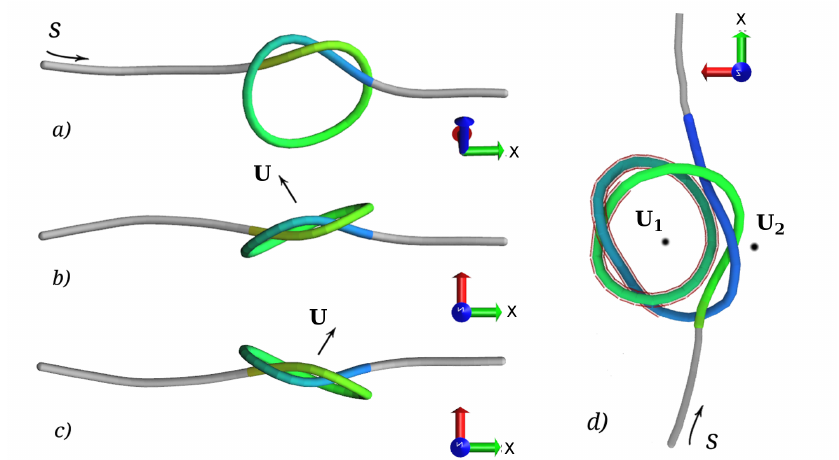
Figure 7. Left-handed 3 1 knot configuration obtained by minimizing the energy viewed from the side ( a ) and from the top ( b ); ( c ) Right-handed 3 1 knot viewed from above. X indicates the pulling direction. In ( a ), the direction of the arc length s is indicated by an arrow, and in all panels by the coloring of the knots, from green to blue for increasing s . In panels ( b , c ), we reported the direction of the vector U k defined in Equation (9). Note that U k · x changes sign with the handedness of the knot; ( d ) A ( + − ) intertwined composite knot, with the nested knot highlighted by a red shading. Note that when the loop of the nested knot lies inside the loop of the outer knot, both orientation directors point out of the page. On the other hand, when the loop of the two knots form an eight, the two directors point in opposite